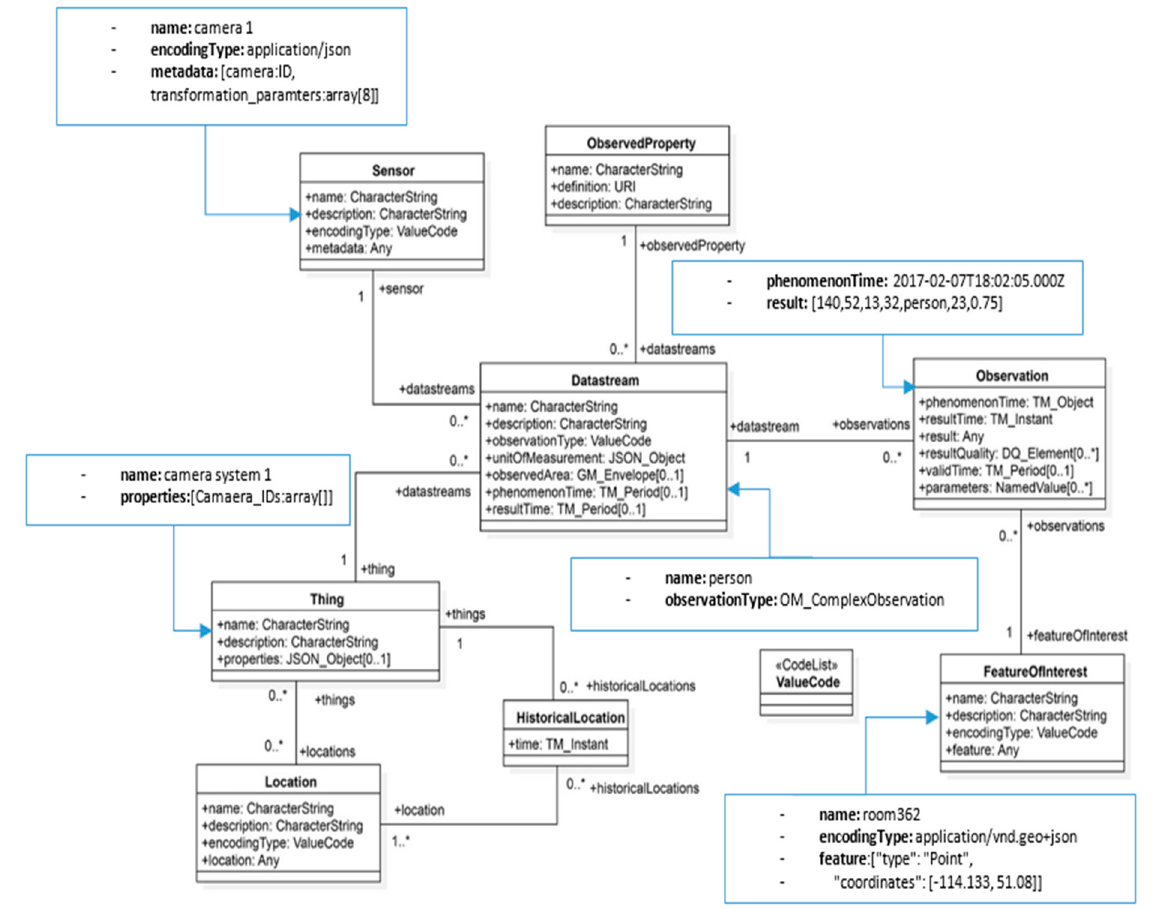
Figure 4. Proposed data model based on SensorThings API.